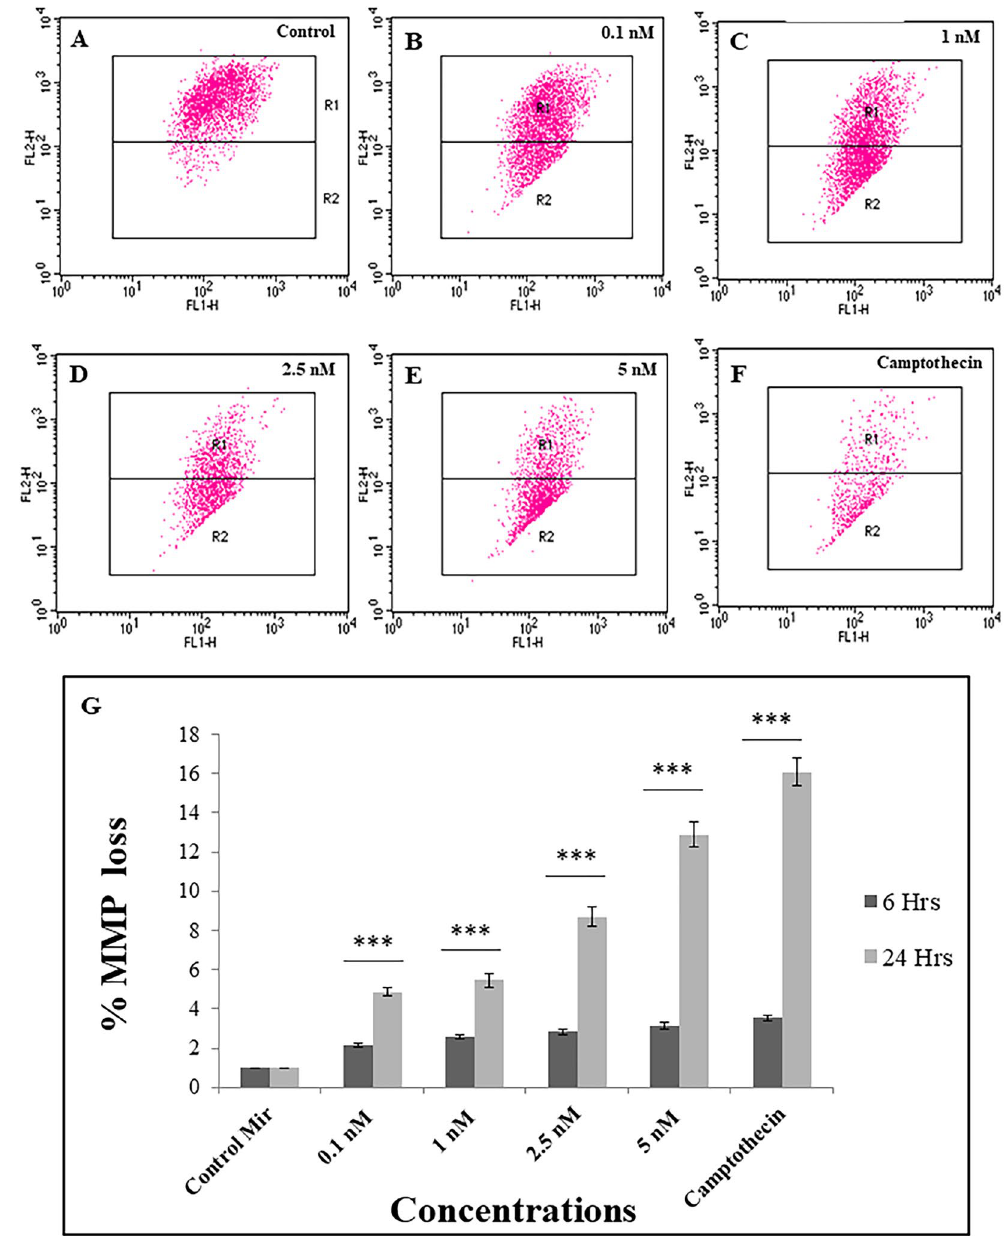
Figure 5. Evaluation of mitochondrial membrane potential (MMP) in MCF-7 cells using flow cytometer. ( A – E ) Flow cytometric scatter plot for JC-1 in cells treated with different concentration of miRNA coated AuNPs ( F ) camptothecin ( G ) Bar graph represents the percentage of JC-1 monomer positive cells (%MMP loss). Values represents mean ± S.E. of three independent experiments (*p < 0.05, **p <